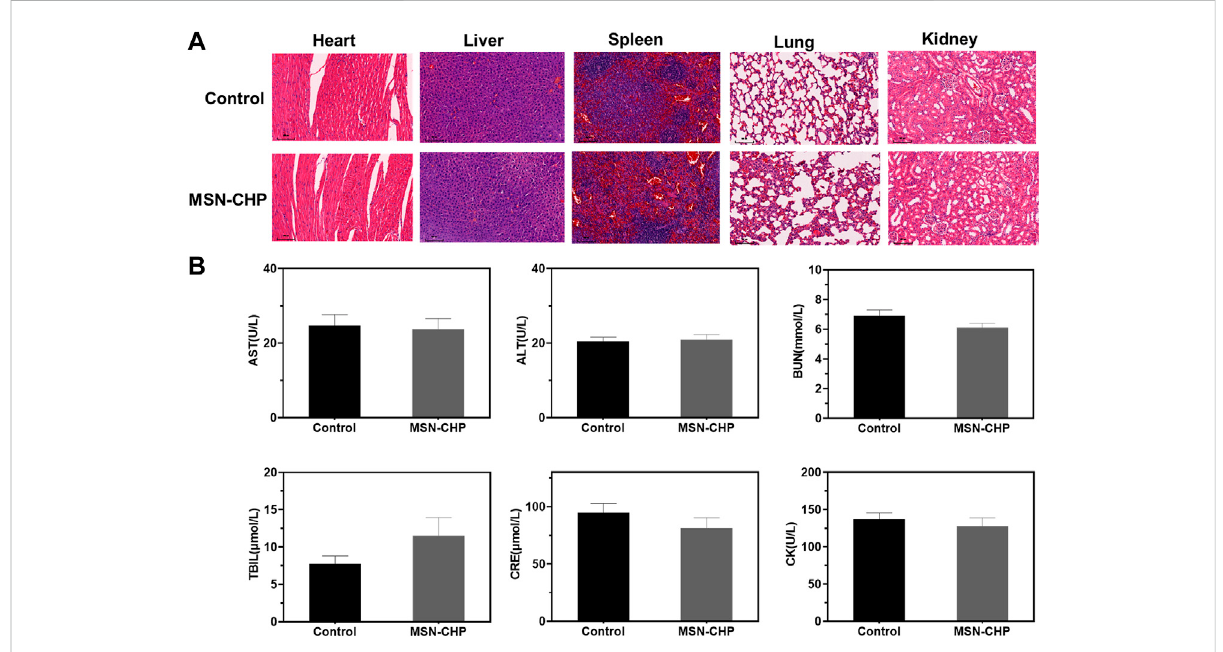
FIGURE 6 H&E-stainedphotographsofmajororgansafter3 daystreatmentofPBSandMSN-CHP (A) .BloodbiochemistryresultsfromPBSandMSN-CHP treated mice, respectively (B)